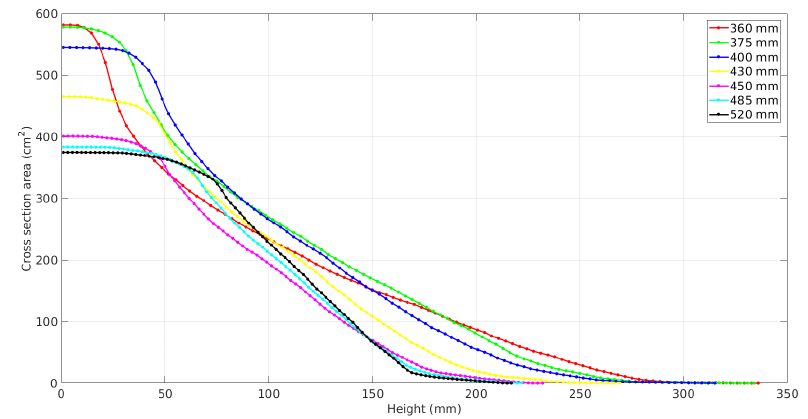
Figure 14. Cross sections area curves of the model scanned at different altitudes from the ground